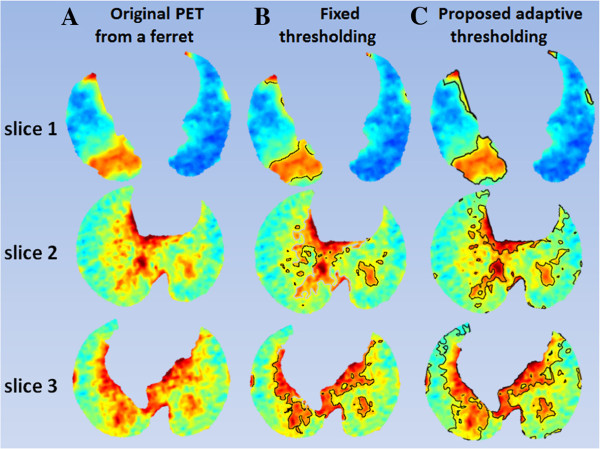
Three different PET slices of a ferret are shown in the first column. While PET slices in column (A) show original images, delineations resulting from the fixed and the proposed adaptive thresholding methods are shown in columns (B) and (C), respectively.